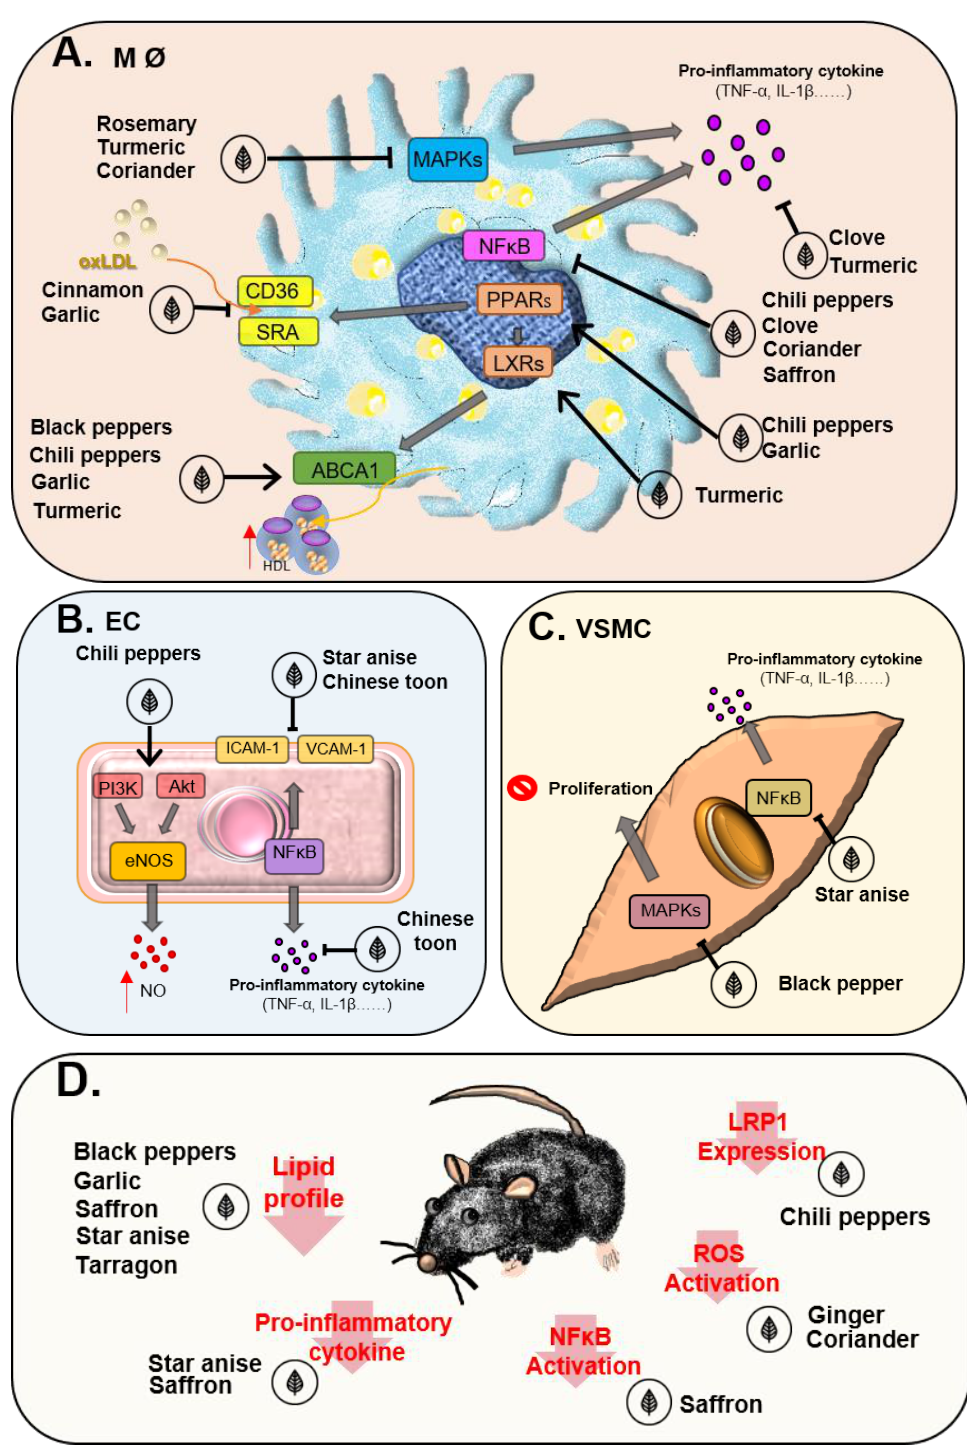
Figure 1. The atheroprotective effects of spices in vitro and in vivo. The atheroprotective effects of spices in macrophages ( A ), endothelial cells ( B ), smooth muscle cells ( C ) and animal model ( D ).